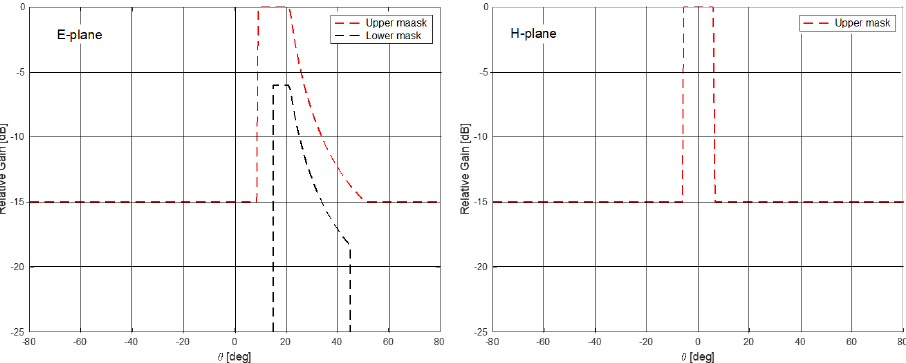
Figure 3. Masks implementing the constraints on the radiation pattern. ( left ): cut in the E-plane; ( right ): cut in the H-plane.